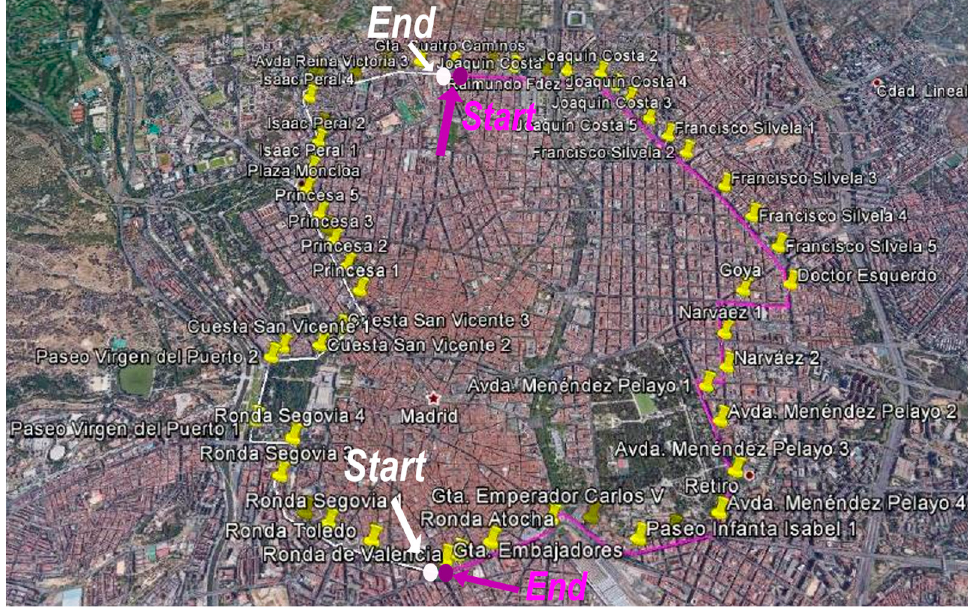
Figure 2. On-road standard testing route. Circular C1 Bus line (purple section shows route 1; white